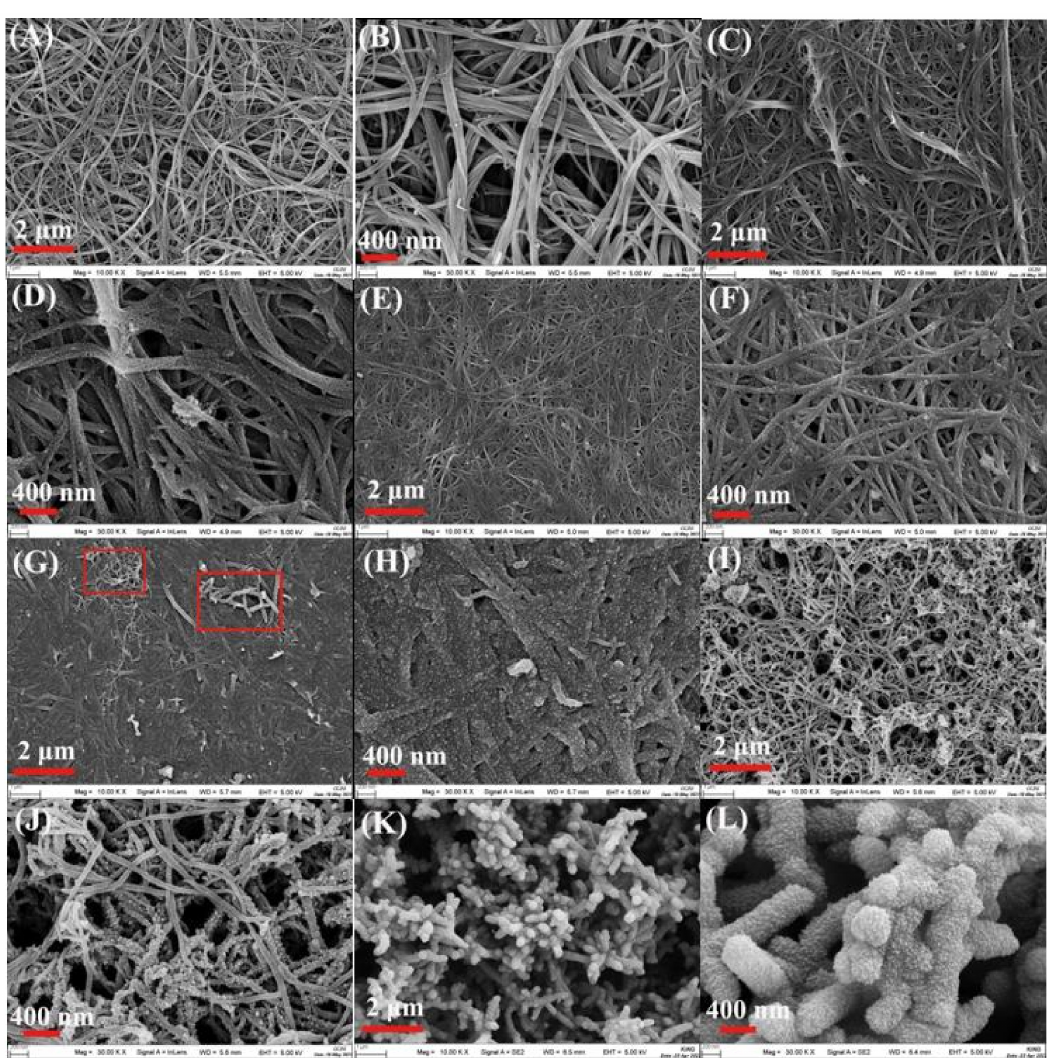
Figure 2. ( A , B ) FESEM images of the acidified CNTF; ( C , D ) CNTF/PANI-1C nanocomposites; ( E , F ) CNTF/PANI-3C nanocomposites; ( G , H ) CNTF/PANI-5C nanocomposites; ( I , J ) CNTF/PANI- 10C nanocomposites; and ( K , L ) CNTF/PANI-15C